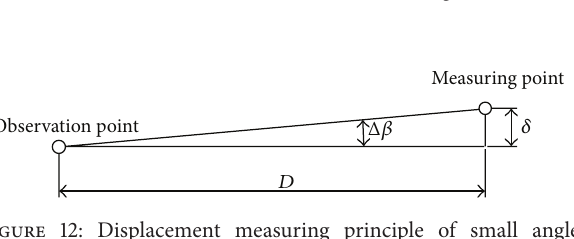
Figure 11: Internal strain change curve: (a) strain in radial direction; (b) strain in hoop direction.